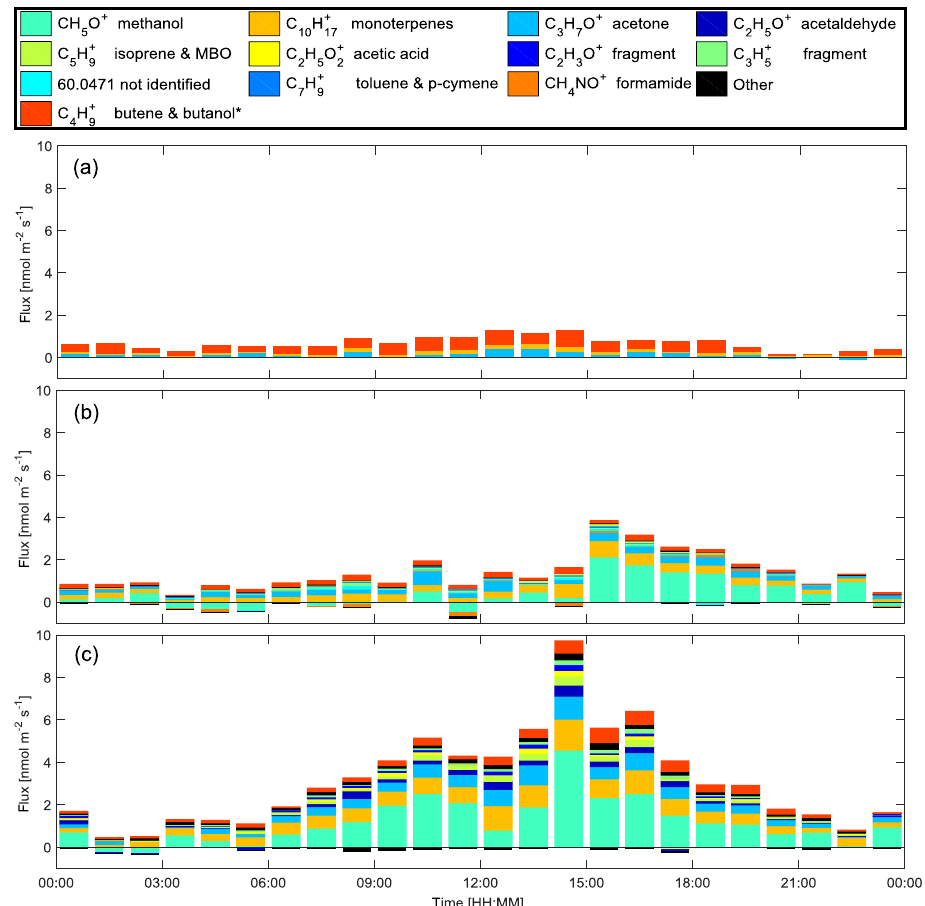
Figure 4. Diurnal pattern of the nine compounds with the highest fluxes, the remaining compounds being summed up as “other”. The panels show the fluxes for snowmelt (a) , start of growing season (b) and summer (c) . The number of data points per hour is dependent on the quality criteria filtering and whether it is in an hour when the automatic background was measured. ∗ The butene + butanol exchange is anthropogenic and thereby not emitted by the forest (Sect.